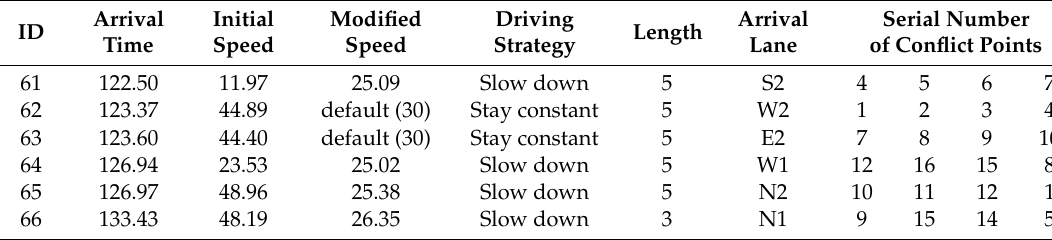
Table 6. Motion information in multi-vehicle collisions.